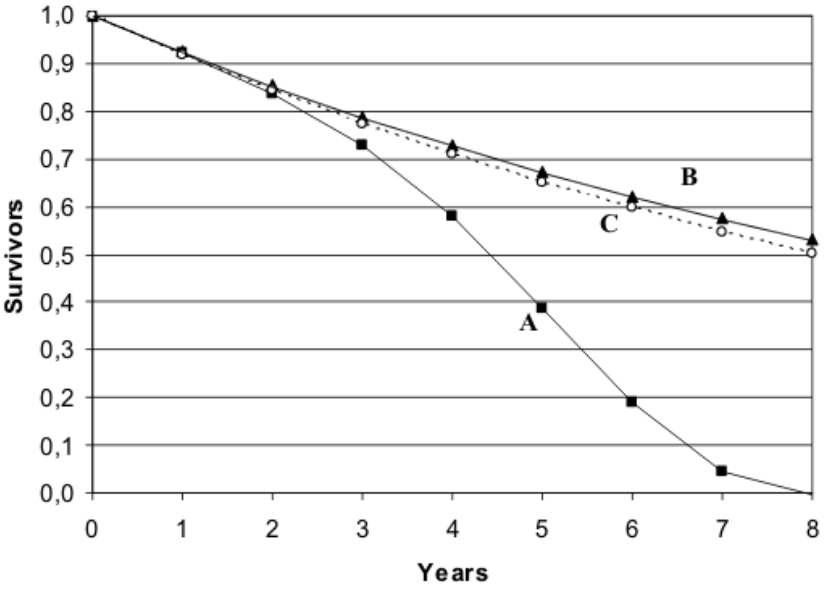
FIGURE 2 . Effect of many t-genes on a life table (for explanations, see